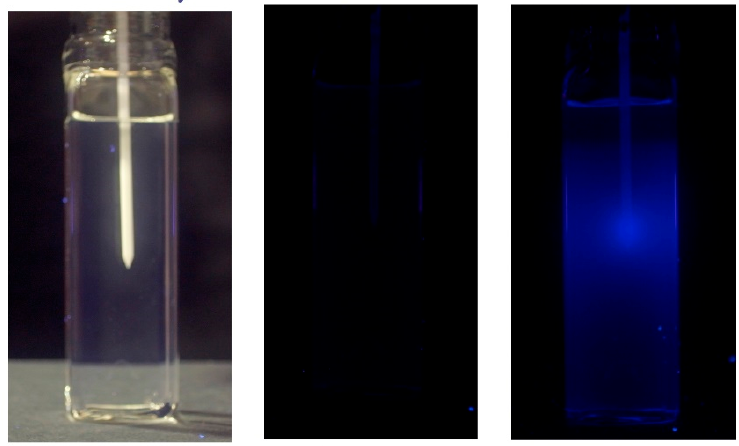
Figure 15. A 20 × 20 mm 2 square, 60 mm long RFG gel with a catheter inserted via a septum seal for insertion of a high dose rate seed of Iridium-192. Left : In room lighting prior to seed loading. Middle : In UV light prior to seed insertion. Right : In UV light 3 minutes after seed insertion.